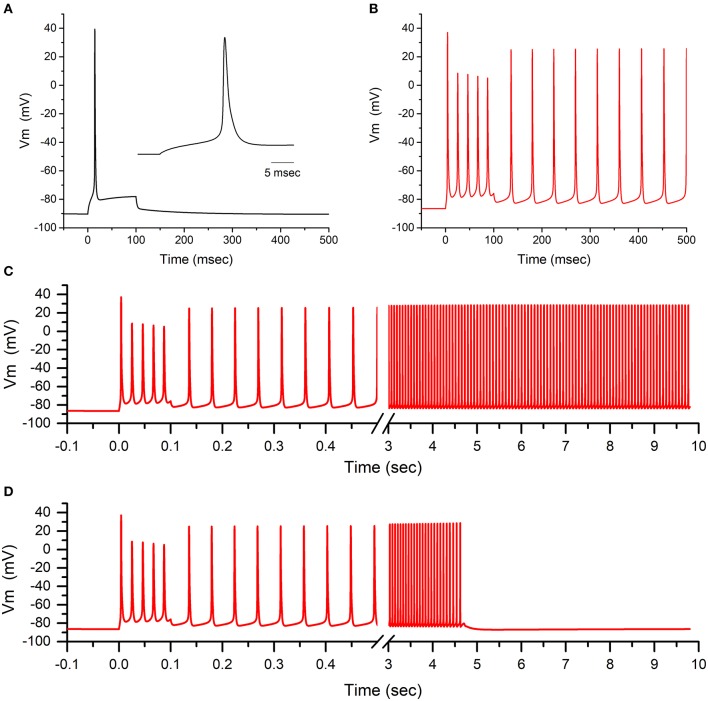
Model simulation predicts sustained busts of myotonia from the L796V channel defects. (A) The action potential elicited by a 20 μA/cm2 current pulse applied for 100 ms is shown for a simulated muscle fiber with normal values for voltage-activated ion channels. Inset shows the initial 25 ms of the model simulation. (B) When 50% of the simulated sodium channels are modeled using parameters to emulate the altered behavior of L796V channels, then the same 100 ms current stimulus triggers a burst of myotonic discharges that persist beyond the 100 ms duration of the stimulus. (C) Extended simulation over time shows stable self-sustained repetitive myotonic discharges that do not cease. (D) When the simulated mutant channels are modified to have the slow inactivation kinetics for WT channels, then use-dependent reduction of the sodium current is enhanced (see this figure) and the myotonic burst ends after 4.5 s.